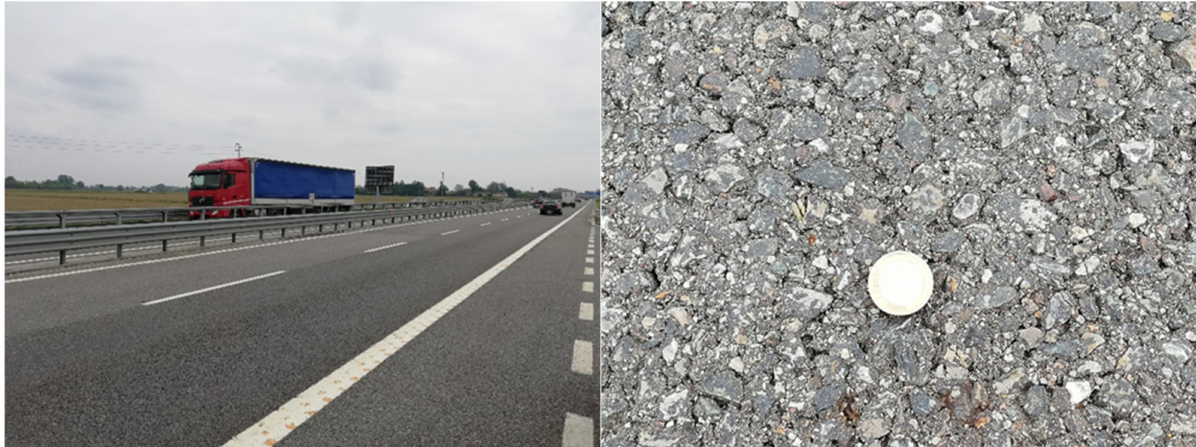
Figure 14. Pavement condition during the annual visual inspections on autumn 2021.The scale coin is EUR 1; 23.25 mm.